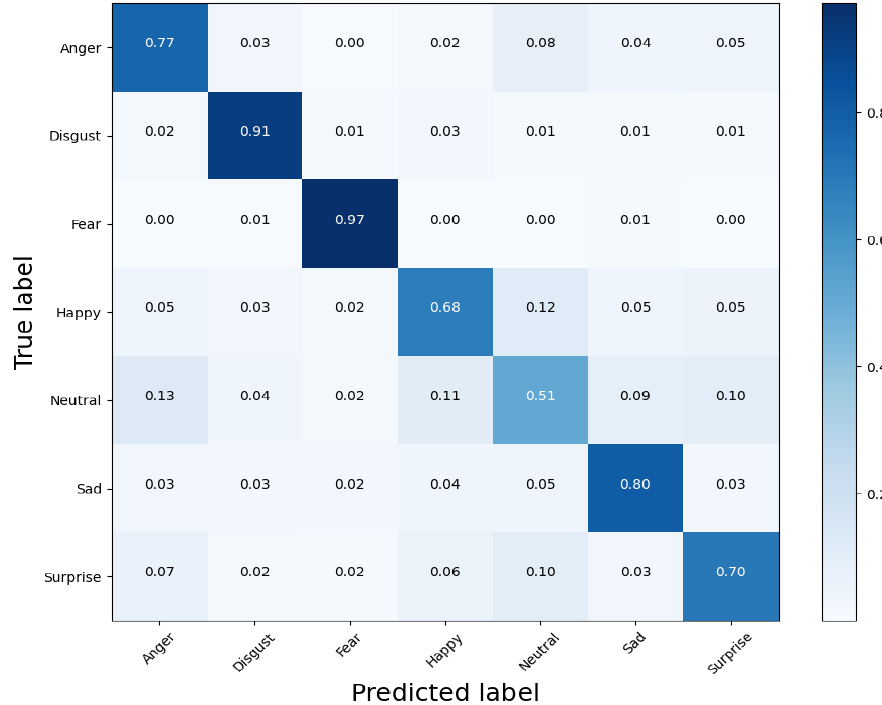
Figure 10. The confusion matrix of MCF-Net(ResNet18) on CAER-S dataset.